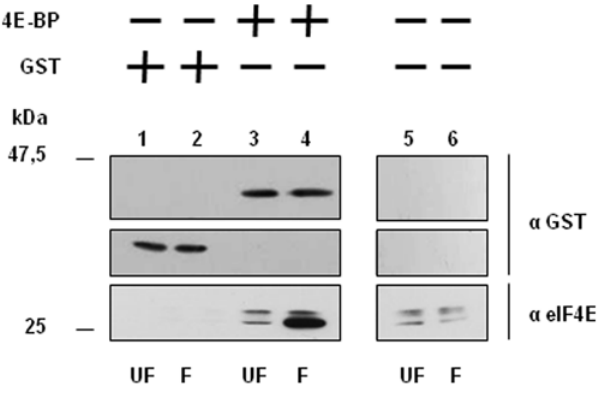
Figure 2. Recombinant GST-Sg4E-BP (4E-BP) interacts with endogenous SgIF4E isoforms in sea urchin extracts. After incubation of the GST alone (lanes 1–2) or the GST-Sg4E-BP protein (lanes 3–4) in extract prepared from unfertilized eggs (UF, lanes 1 and 3) or from 60 minutes post-fertilization embryos (F, lanes 2 and 4), proteins were affinity purified using Gluthatione Sepharose 4B beads, diate panels) or anti-eIF4E antibody (bottom panels) as described in Materials and Methods. SgIF4E that co-purified with GST-Sg4E-BP (lanes